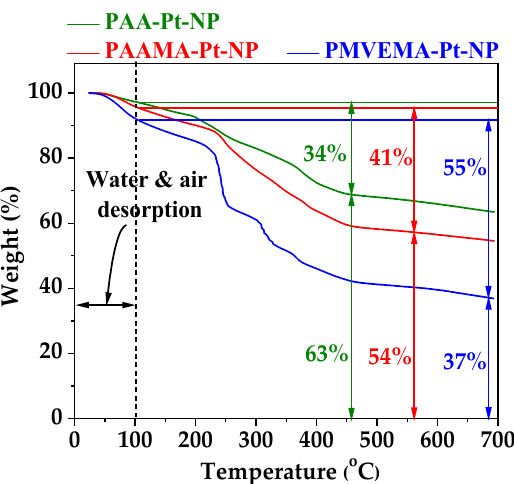
Table 3. Summary of the surface-coating amount.